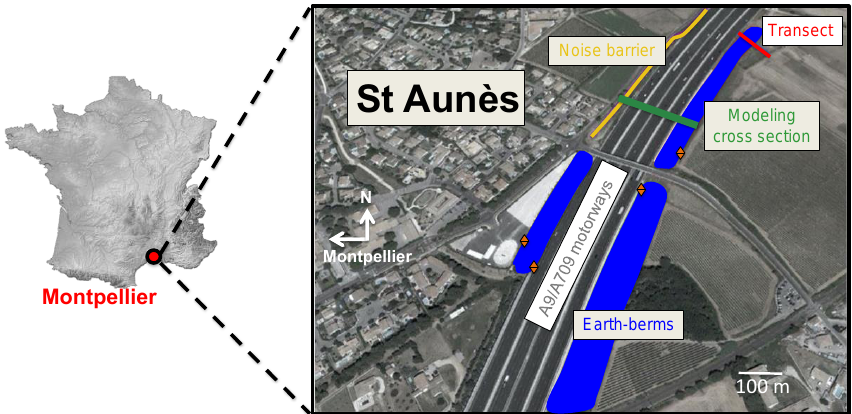
Figure 1. Map of the study area locating in blue the three flat-top berms; the one roofed with a precast noise barrier is in yellow, and the soil samples transect is in red. Orange arrows indicate the location of the regional air agency PM microsensors, and the green line illustrates the location of the modeling cross-section. Image from Google Earth V7.3.3.7721. digital Globe 10 July